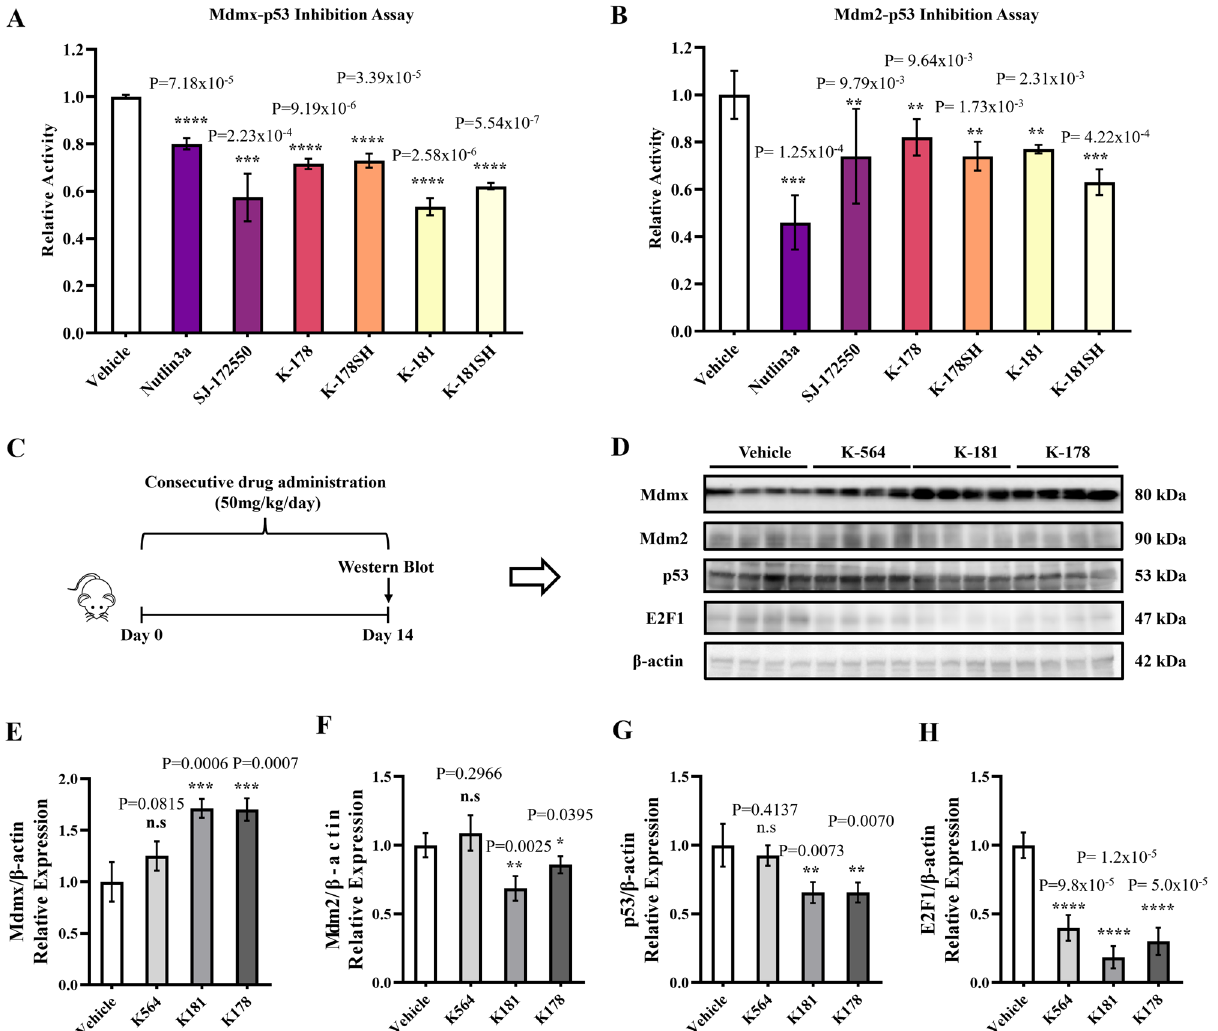
Figure 2. K-181 increased Mdmx expression in mice brain under physiological condition. ( A , B ) Relative inhibition activity on Mdmx–p53 ( A ) and Mdm2–p53 ( B ) interaction using chemical compounds at 12.5 μM. N = 3. ( C ) Mice were orally administrated with K-181, K-178, K-564 and vehicles at 50 mg/kg/day for consecutive 14 days. ( D – H ) Western blot ( D ) and quantification of Mdmx ( E ), Mdm2 ( F ), p53 ( G ) and E2F1 ( H ) in mice brains. N =